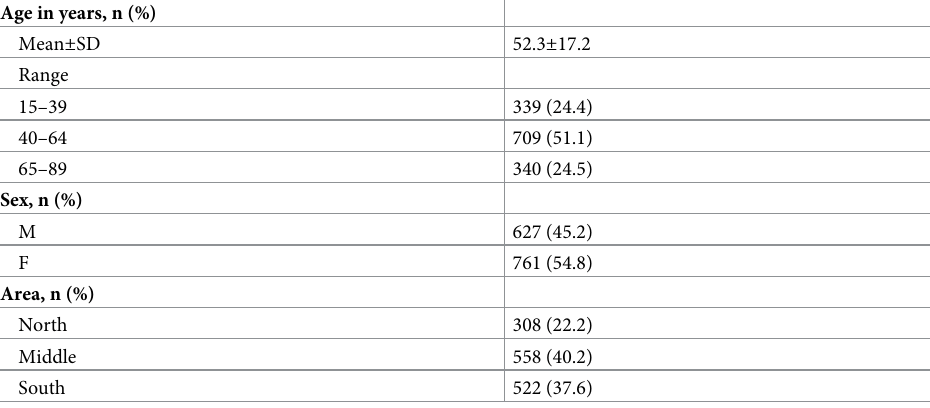
Table 1. Characteristics of the study participants (n = 1,388).